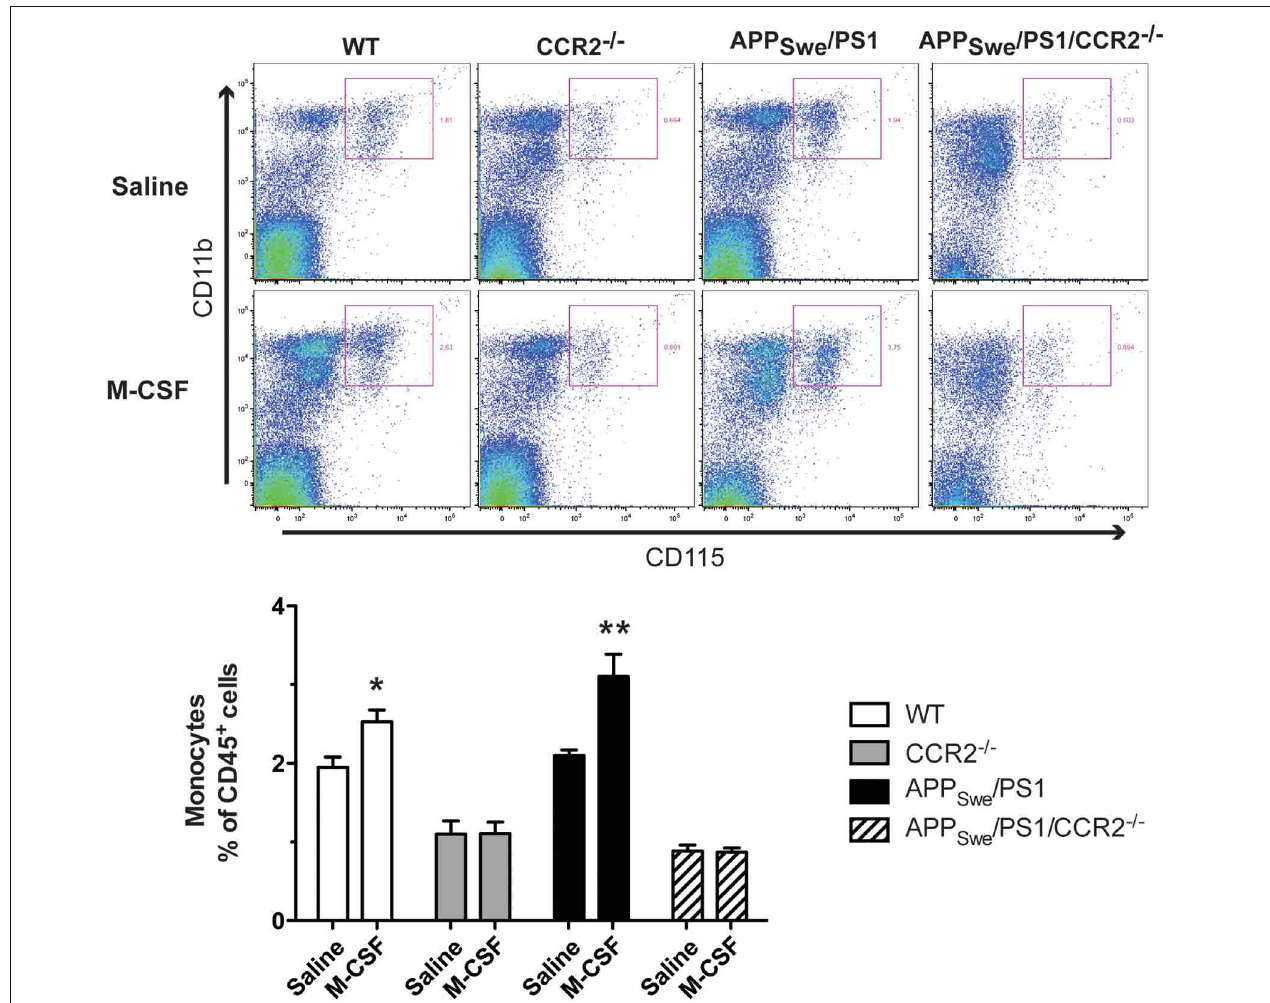
FIGURE 9 | Short M-CSF treatment increases monocyte frequency in WT and APP Swe /PS1 mice in a CCR2-dependent manner. Monocyte frequency was determined by FACS analysis within the population of CD45 + cells using the CD11b and CD115 markers in WT, CCR2 − / − , APP Swe /PS1, and APP Swe /PS1/CCR2 − / − mice. Mice received saline or M-CSF treatment during 4 days (40 μ g/Kg/day) at the age of 4 months and blood samples were